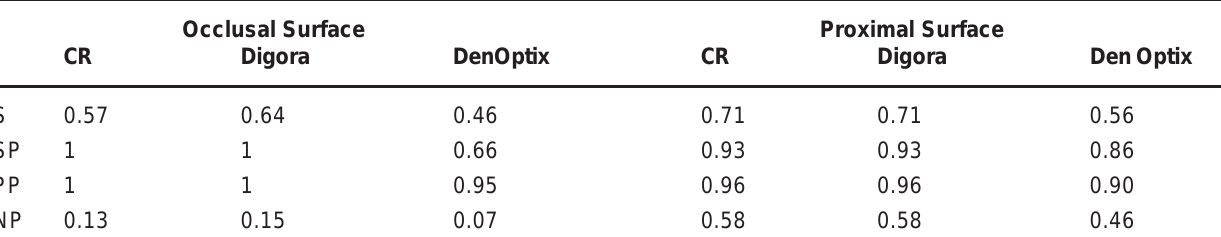
TABLE 3- Values of Sensitivity (S), specificity (E), positive predictive (PP), Negative predictive (NP) for the